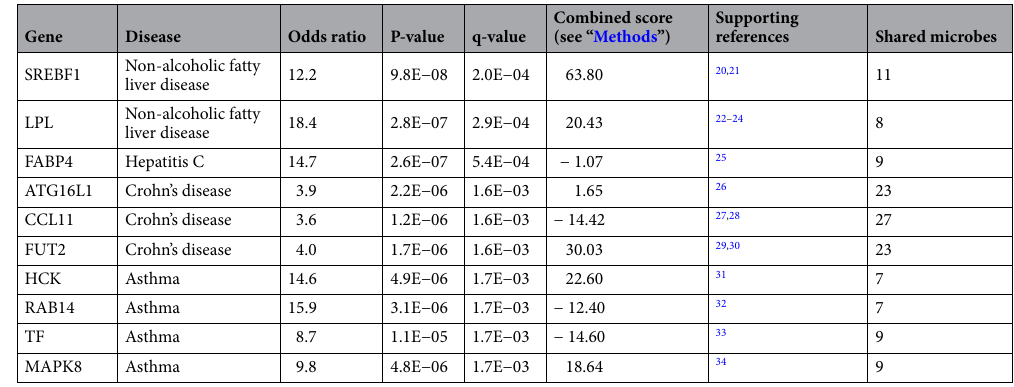
Table 3. Top enriched gene-disease connections via microbes identified using